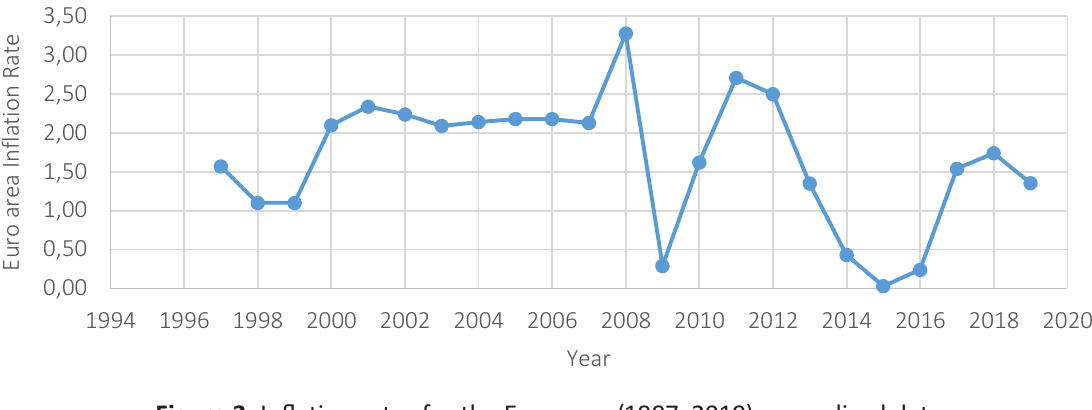
Figure 3. Inflation rates for the Euro area (1997–2019), annualized